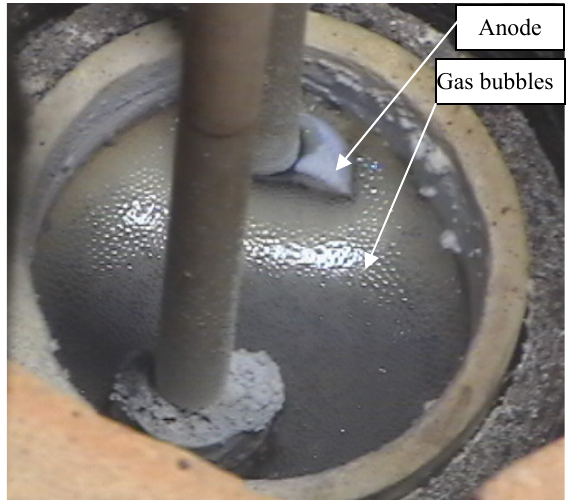
Figure 3. Electrolysis cell and anode bubbles evolution from